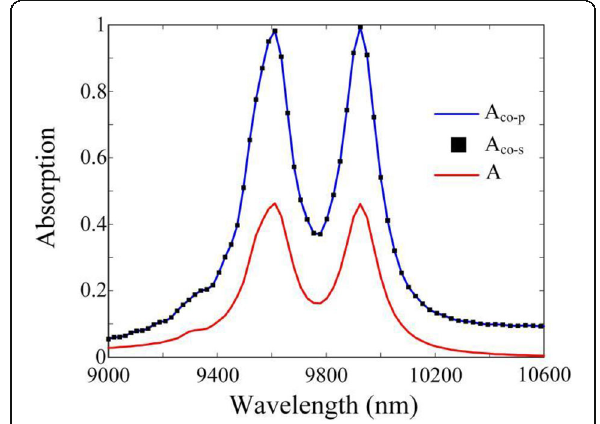
Fig. 3 The absorption spectra of the proposed graphene-based absorber under the illumination of only one incident beam (red curve), and under coherent illumination with p polarization (blue curve) and s polarization (black